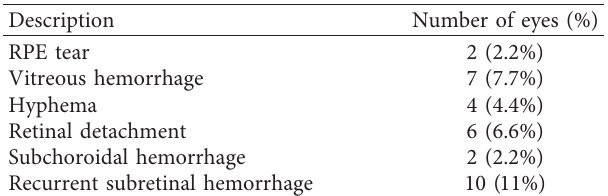
Table 2: Adverse events recorded during the postoperative follow-